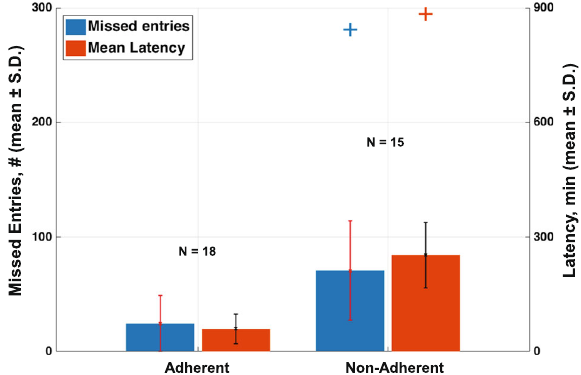
Fig. 2 Adherence to motor diaries. All 34 participants in the 4th study were asked to complete an electronic motor diary during the fi rst 3 days of each week of at-home monitoring. One participant ’ s data were lost due to technical failure of their phone. Among the remaining 33 participants, adherent participants ( n = 18) rarely missed entries (24.4 ± 24.4 missed) and had low latency to response (59.4 ± 38.6 min), whereas non-adherent participants (n = 15) missed entries more often (70.8 ± 43.5 missed) and took longer to complete those they did not miss (253.0 ± 85.5 min). Data are shown as the mean value, plus, or minus the standard deviation for each